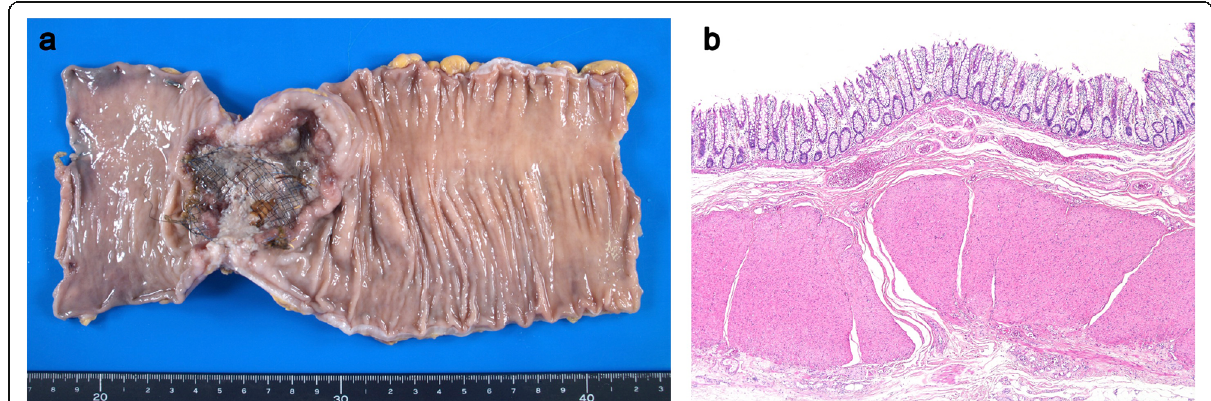
Fig. 5 a Image of the surgical specimen showing a circumferential rectal tumor with placement of self-expanding metallic stent. b Histopathological image showing the absence of intestinal edema on the oral side (× 40, H&E